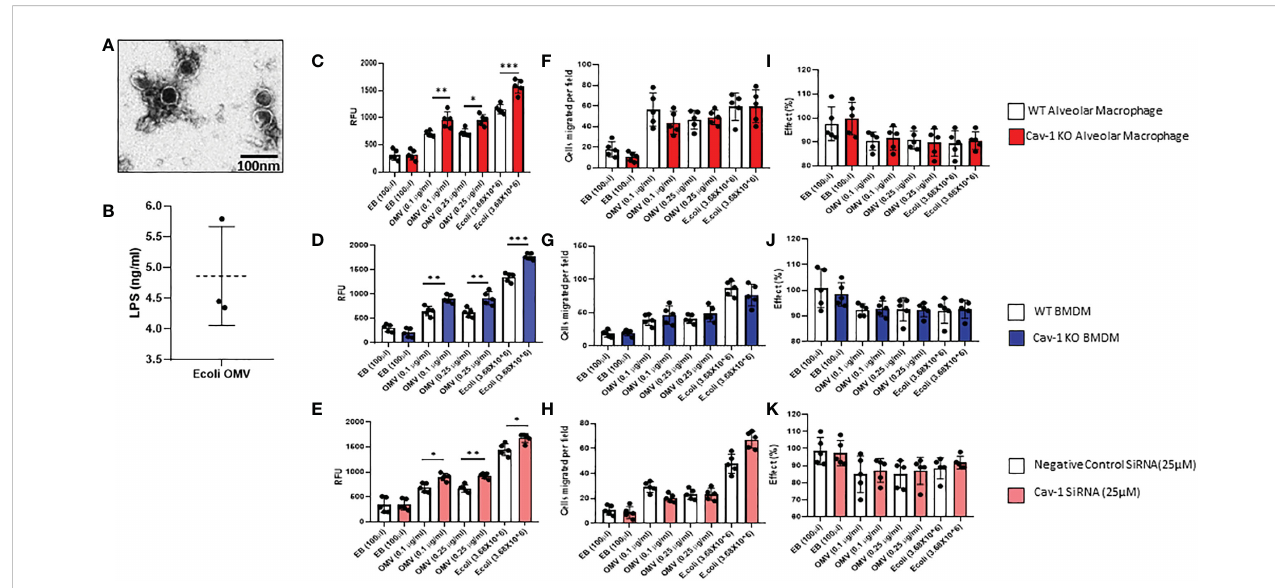
FIGURE 1 Effect of OMVs on WT and Cav-1 KO AM Ф , BMDM, and human THP-1 cells. (A) Representative Transmission electron microscopy (TEM) image of OMVs isolated from E. coli (scale bar=100nm). (B) Graphical representation of LPS presence in E.coli OMVs was quanti fi ed using a competitive inhibition ELISA method (n=3). Cells were treated with different concentrations (0.1 and 0.25 m g/ml) of OMVs or E. coli (3.68X10 6 ); after 24h, OMV-induced ROS secretion in all the macrophages using the CM-H2DCFDA assay method (C – E) . Migration assay of OMV-treated AM, BMDM, and THP-1 cells. Cells were treated with OMVs (0.10 or 0.25 m g/ml), and their migration was assessed (F – H) . Effect of OMV on Phagocytosis in macrophages (I – K) (n = 5). Results were expressed as mean ± SD. Statistical Analysis was performed non-parametrically using the One-way Analysis of variance (ANOVA) with Tukey ’ s multiple